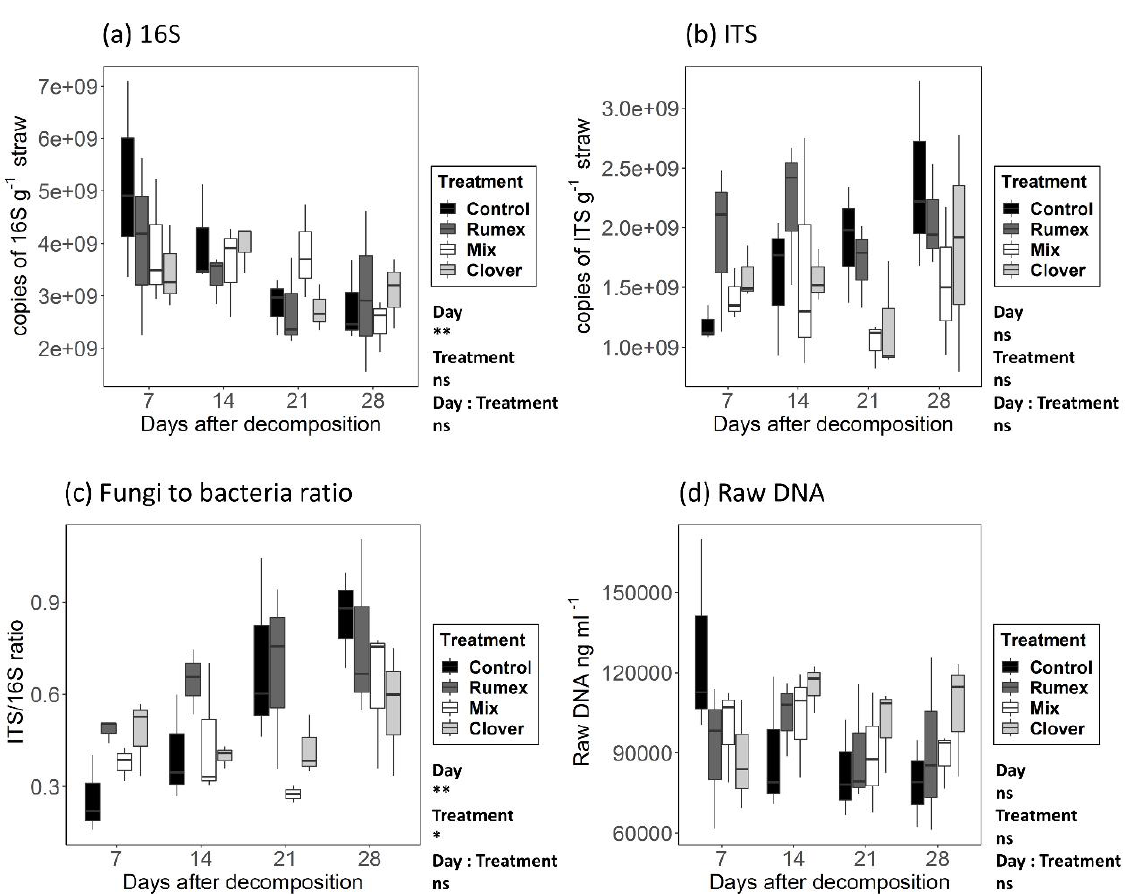
Fig. 5 16S bacterial abundance (a), ITS fungal abundance (b), fungi-to-bacteria ratio (c), and raw DNA abundance (d) at 7, 14, 21, and 28 days under the control, Rumex , mix, and clover treatments The level of significance was determined using two-way ANOVA. “Day: Treatment” shows the interaction between the day and treatment effects. *, p < 0.05; **, p < 0.01; ns, not significant. Error bars represent standard deviations of mean values (n =